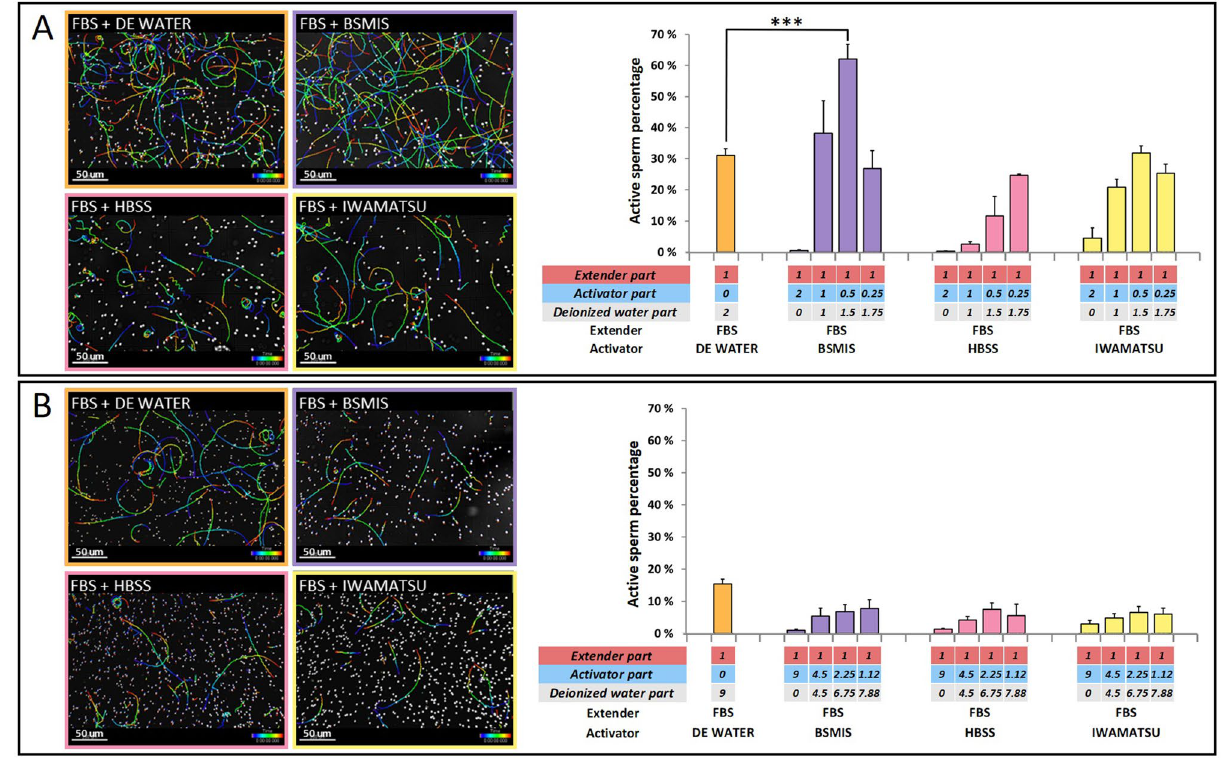
Figure 2. Fresh sperm activation using FBS as extender and different buffers for dilution. ( A ) Image tracking of sperm movements and quantification of directional sperm, using FBS extender solution mixed in a ratio of 1 to 2 with different activating solutions (1 volume of extender solution plus 2 volumes of activating solution at different dilutions). Ratios of extender, activator, and water for each mix are shown below each column. ( B ) Image tracking of sperm movements and quantification of directional sperm, using FBS extender solution mixed in a ratio of 1 to 9 with the different activating solutions (1 volume of extender solution plus 9 volumes of activating solution at different dilutions). Ratios of extender, activator, and water for each mix are shown below each column. Asterisks indicate solutions significantly more effective than tank water in activating sperm, based on a two-way ANOVA post hoc Dunnett’s test. *p < 0.05, **p < 0.01, ***p < 0.001. N = 3 biological replicates for each condition. (Image tracking of sperm movements were exported from Imaris, version 8.1, https:// imaris. oxinst.